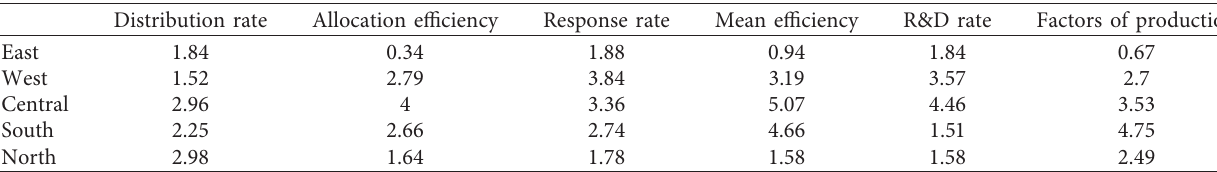
Table 6: R&D resource allocation efficiency in various regions.